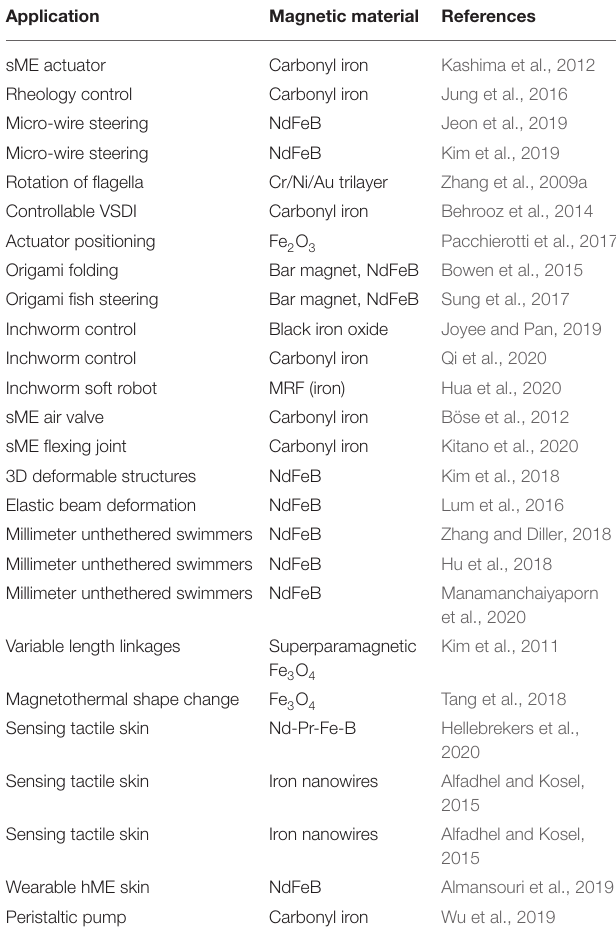
TABLE 1 | MEs in soft robotic